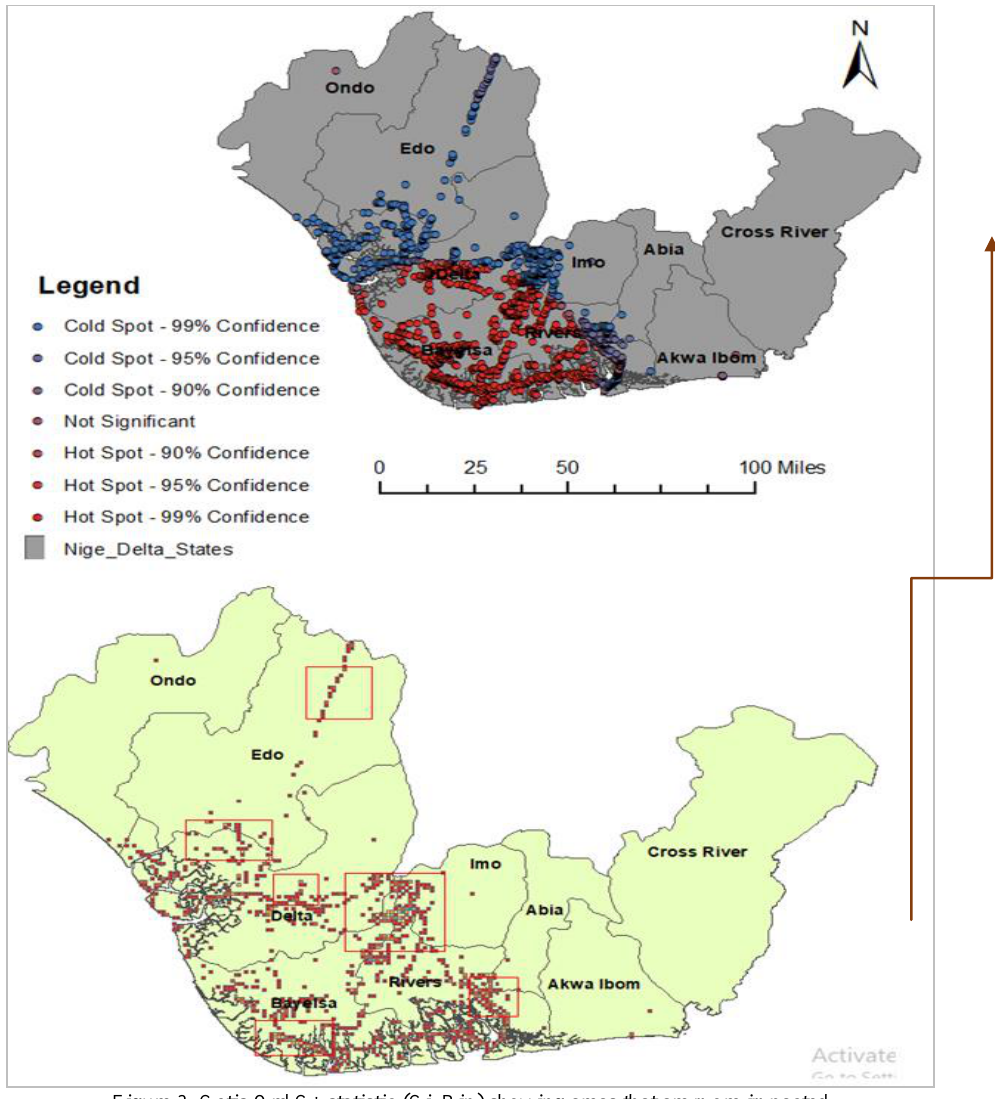
Figure 3. Getis-Ord G* statistic (Gi_Bin) showing areas that are more impacted